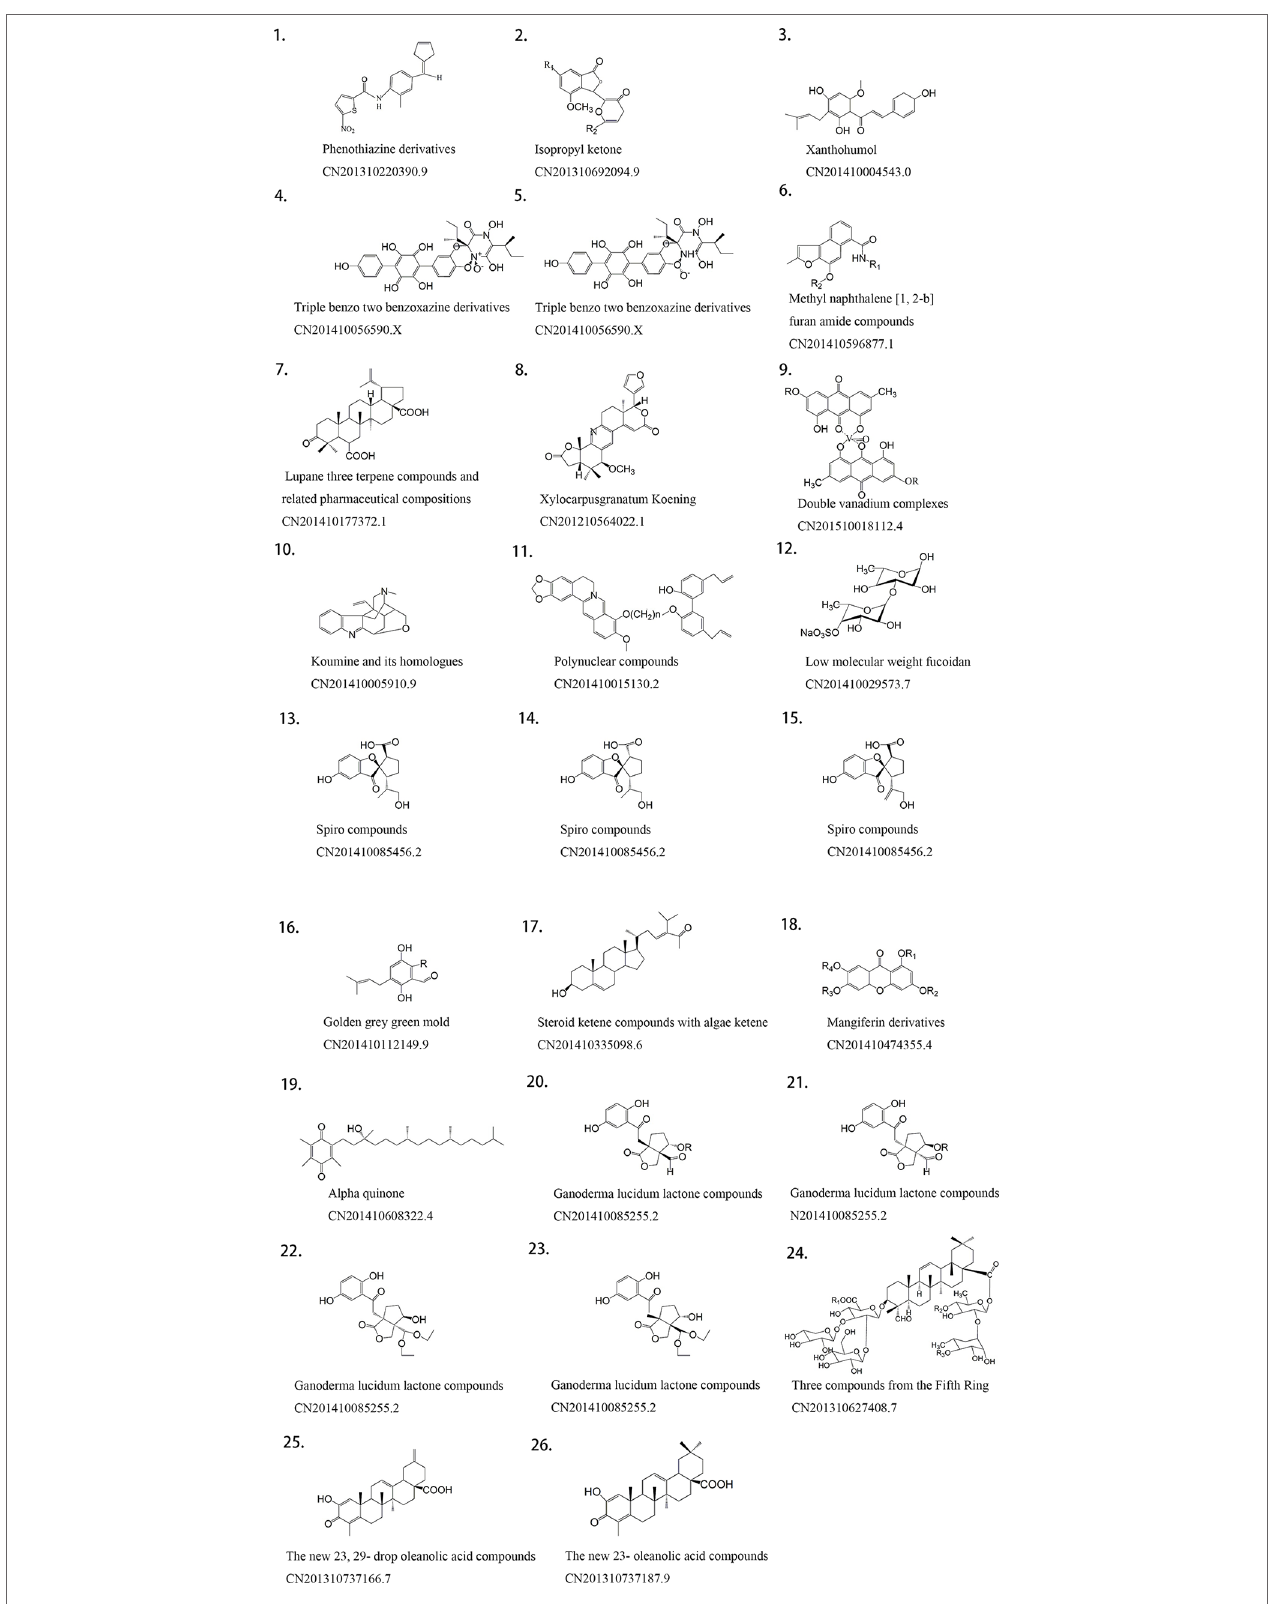
FIGURE 4 | Structure of active phytochemical ingredients of herbal extracts in anti-diabetic properties in Chinese